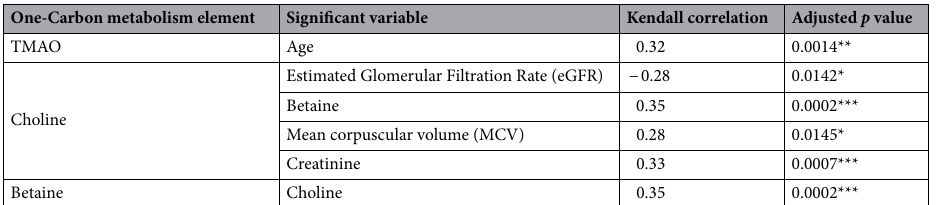
Table 1. Significant correlations between MRC Twenty-07 meta-variables and elements of one carbon metabolism. Bonferroni adjustment was used to generate adjusted p values, where *** = < 0.001, ** = < 0.01, * = <